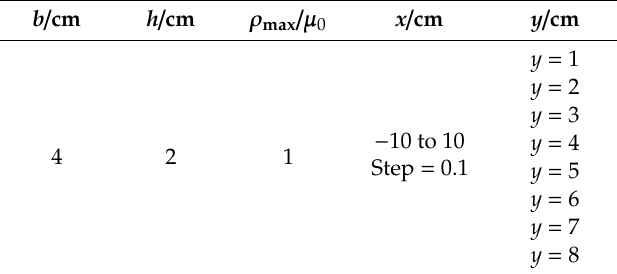
Table A2. The parameter list of MATLAB finite element calculation in Figure 2.